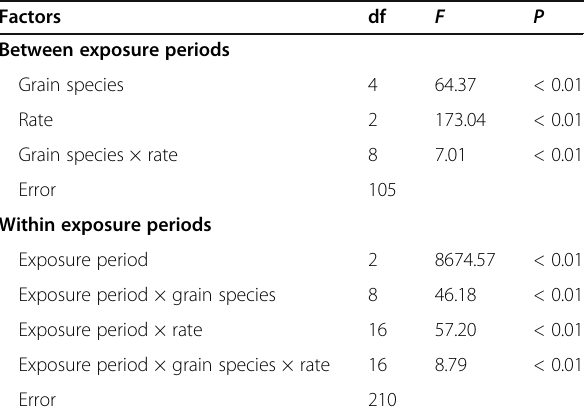
Exposure period × rate Exposure period × grain species ×